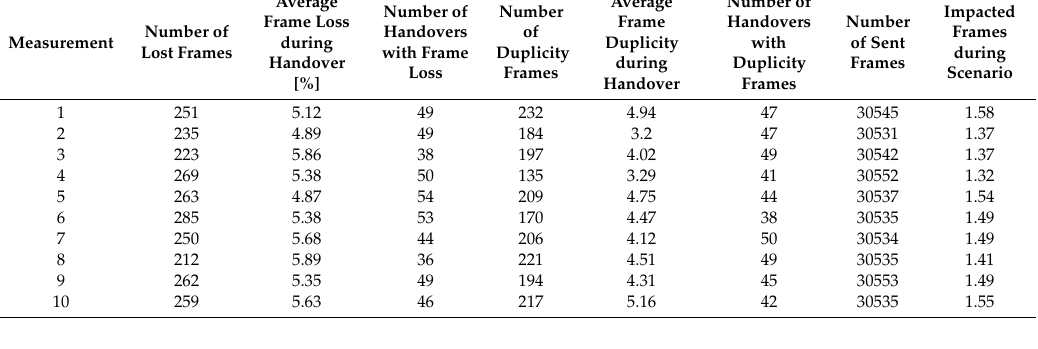
Table 2. Measurements of handover impact on transmitted frames